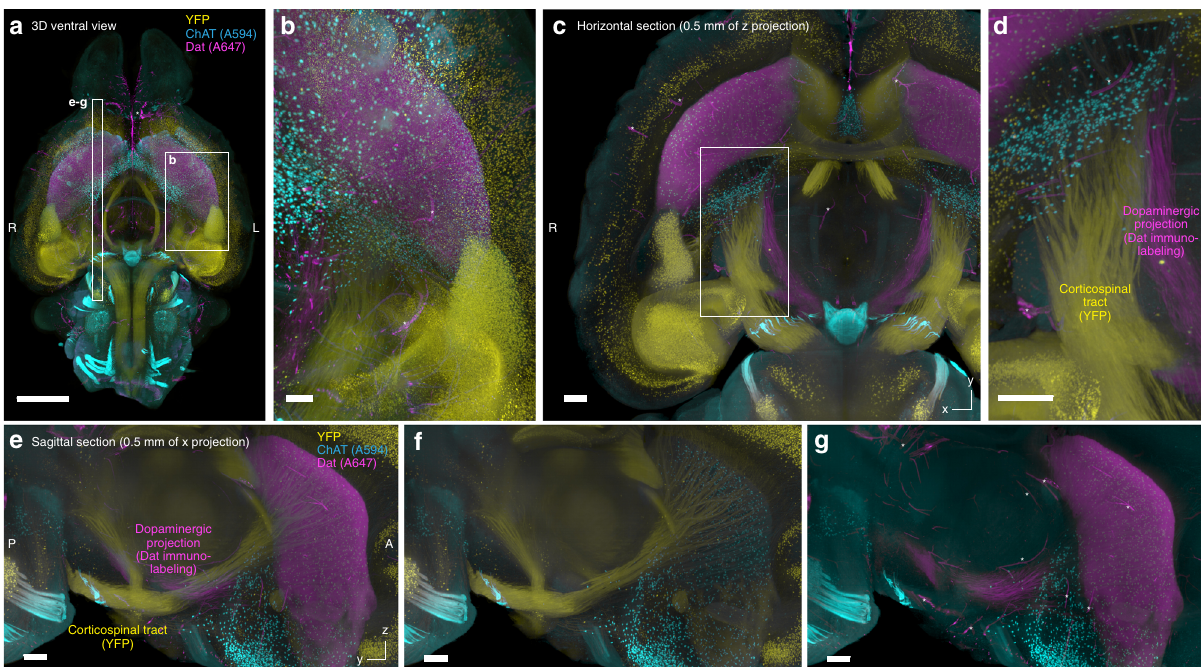
Fig. 6 CUBIC-HV enables multimodal whole-organ labeling and imaging. a - g ChAT (A594) and Dat (A647) double-staining images of the sole Thy1- YFP-H Tg whole adult mouse brain. Voxel size 8.3 × 8.3 × 9 μ m 3 . a Merged image of all three channels. Scale: 2 mm. b Enlarged image at the position indicated in a . Scale: 0.5 mm. c Horizontal view of a representative section. Scale: 0.5 mm. d Enlarged image at the position indicated in c . Neighboring projection tracts labeled with YFP expression or anti-Dat immunolabeling were visualized. Scale: 0.5 mm. e – g Reconstituted sagittal sections at the position indicated in a , visualizing the neighboring projection tracts. Scale: 0.5 mm. Asterisks in e – g indicate nonspeci fi c vascular signals due to insuf fi cient perfusion of the